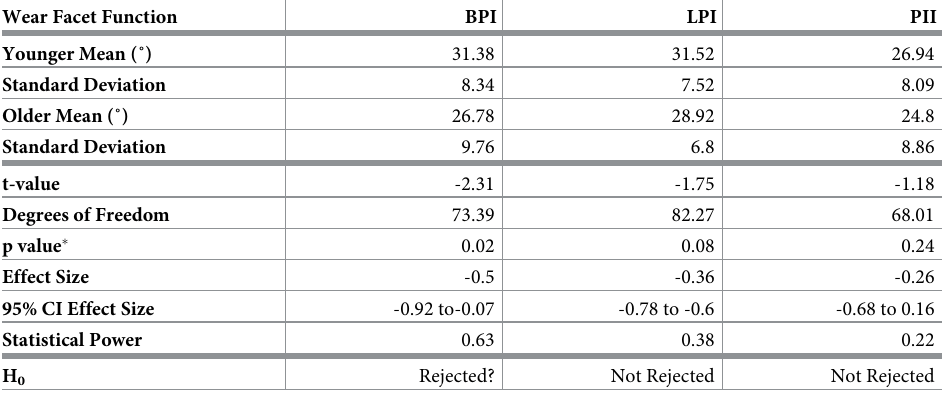
phase I wear facet areas in the pre-industrial group are consistent with a prominent and pro- longed shearing action during the incursive portion of the masticatory stroke [36, 40]. In con- trast, industrial individuals frequently exhibit more poorly developed phase I wear facets alongside wear facet patterns dominated by phase II wear. This occlusal situation reflects a briefer and more vertically directed phase I shearing action, such as designated by small and steep wear facets, and consistent with the consumption of less abrasive and softer food items that do not require extensive transverse jaw movements during oral processing [39, 80–82]. Similarly, the OFA kinematic simulations for each period further indicate a reduction in lateral travel of the lower teeth during the power stroke in the industrial period. Previously assumed differences in the physical properties of the dietary staples consumed in each period are con- firmed by the differences in dental wear facet patterns observed in the current study [14]. The variance in dental wear facet patterns did not differ significantly between the two peri- ods. Nevertheless, variance values are relatively large in both. This might derive from the inclu- sion of individuals of both higher and lower social status within the pre-industrial and industrial samples. In the medieval period, the quality and type of bread consumed varied between social classes. The upper classes ate fine wheaten bread while the lower classes would consume darker and coarser loaves of rye, barley and oats [43]. For the peasantry, dietary sup- plements, such as meat, would have formed as little as 20% of the total calories consumed. This Table 10. Independent sample t-tests assessing age-related differences in dip angle during the industrial period for BPI, LPI and PII wear